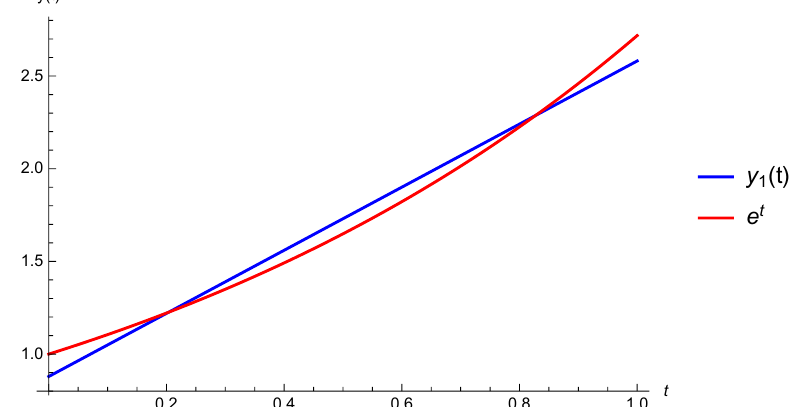
Figure 1. Comparison of approximate and exact solutions of System (12) for the case r = 2 and q = 1. Table 1. Absolute errors in solution of System (12) with r = 2 and q = 1. t Error t